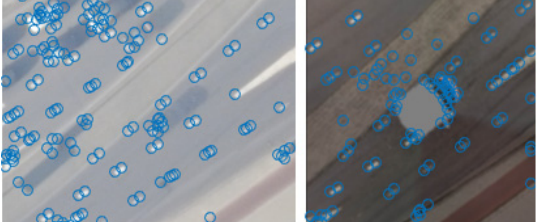
Figure 10 AGAST keypoints in aerial nadir and MM ortho- image